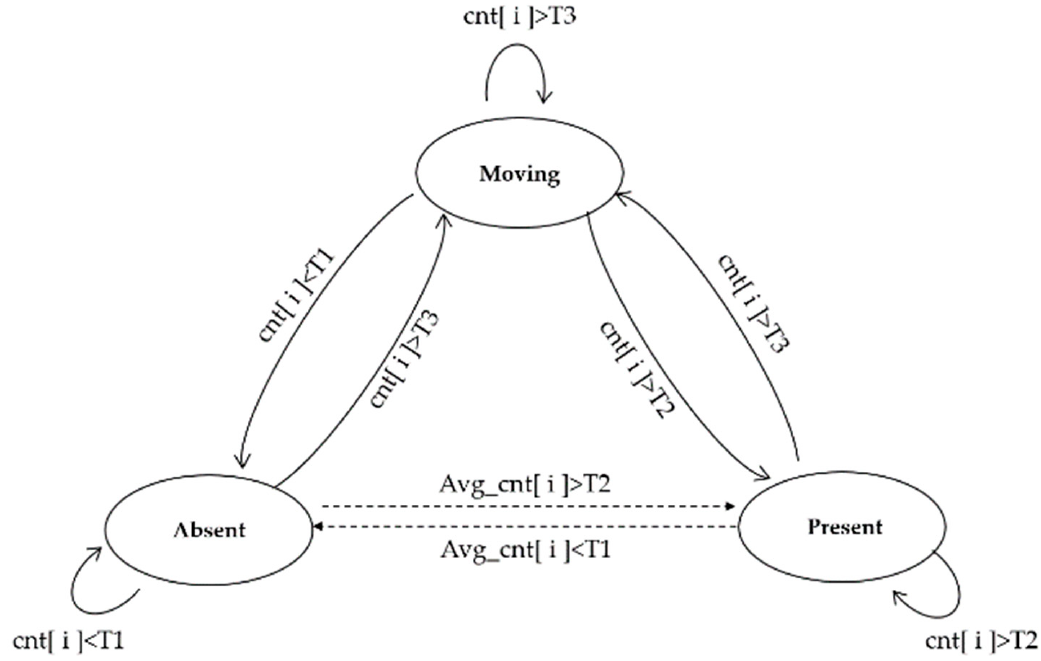
Figure 10. Presence state transfer diagram of a passenger. Algorithm 1 Presence detection based on state machine